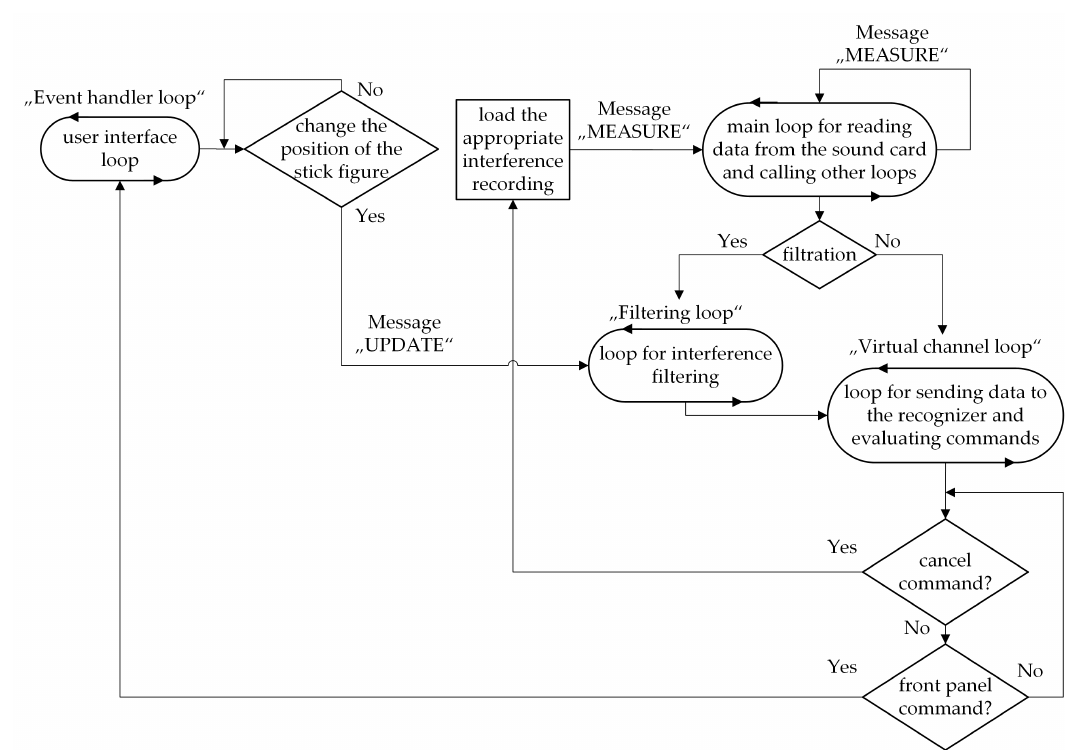
Figure 3. Simplified block diagram of the “smart home”